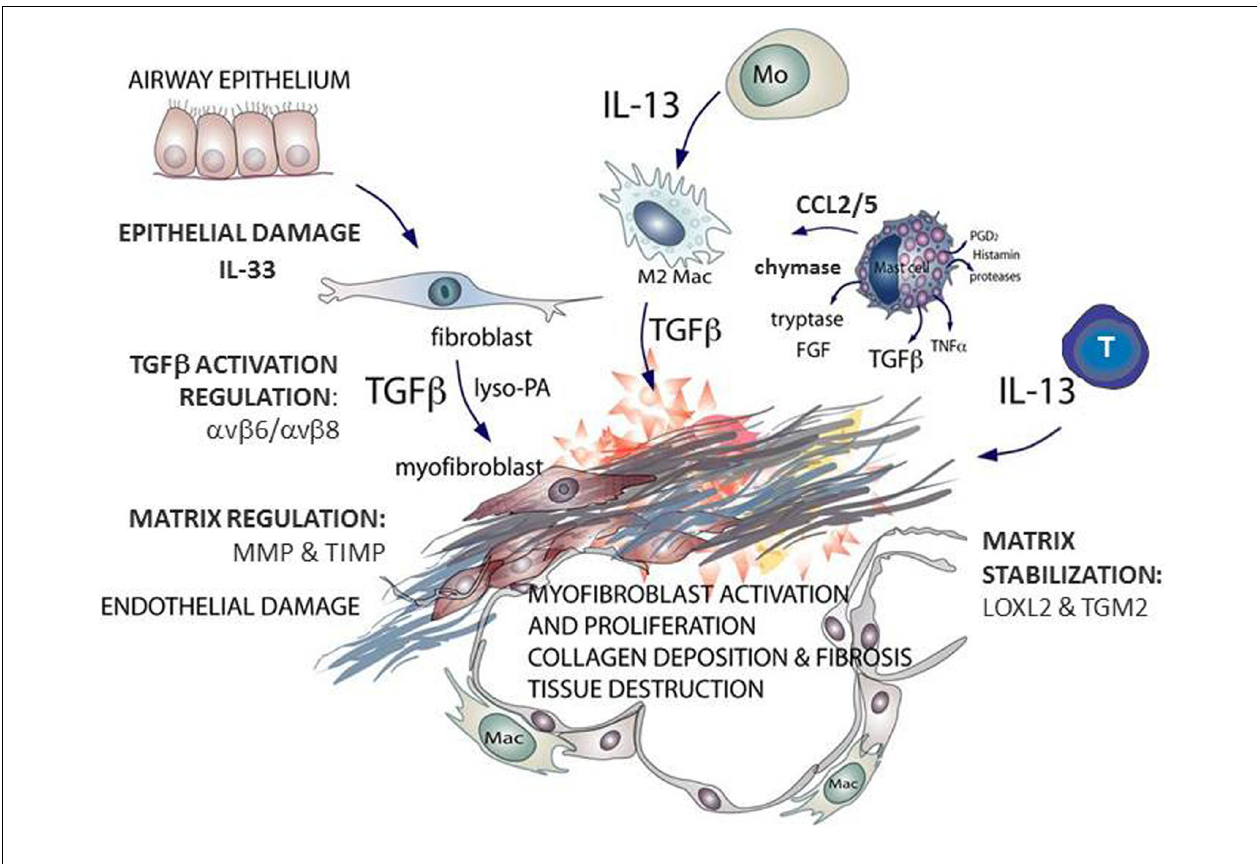
direct producers of extracellular matrix (ECM), or indirectly promote the generation and deposition of aberrant matrix. Mast cells generate pro-fibrotic mediators including tryptase, chymase, and chemokines that promote fibroblast activation. This figure is adapted from Clarke etal.